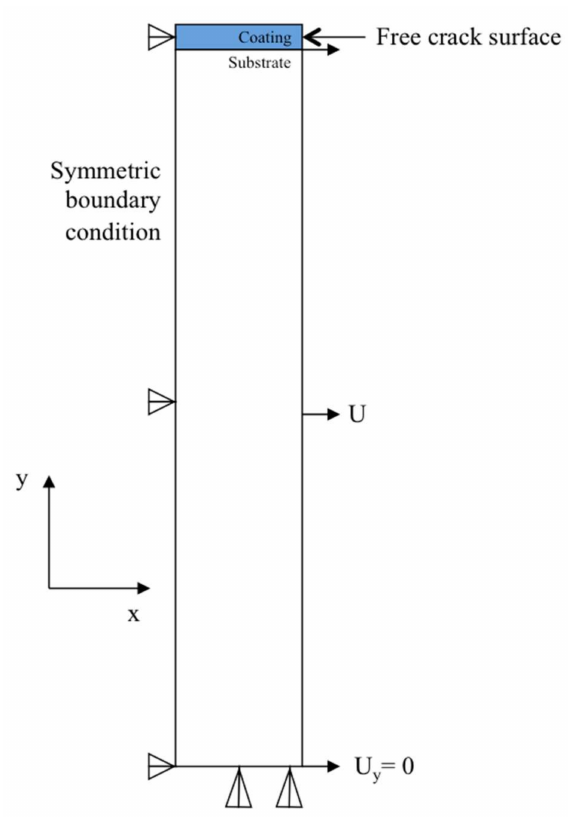
Figure 12. Schematic of the unit cell in finite element method (FEM) model: the cross-sectional geometry of the ceramic-metal interface. x -axis: direction of applied tension; y -axis: direction perpendicular to the plane of the